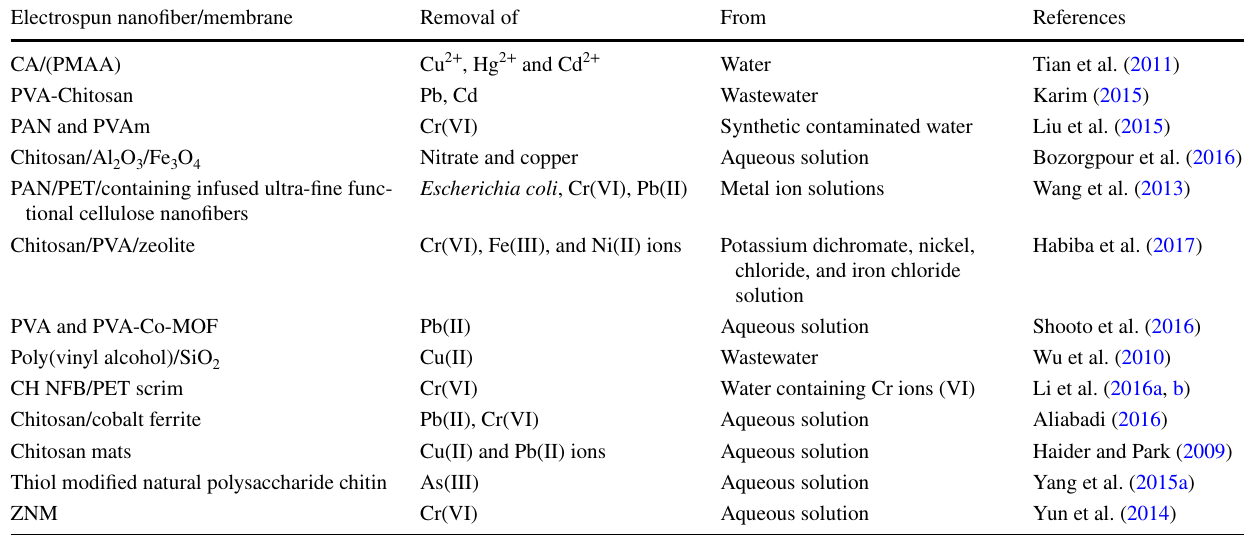
Table 5 Summary of electrospun nanofiber/membrane used for the removal of heavy metals/pollutants from water/wastewater Electrospun nanofiber/membrane Removal of